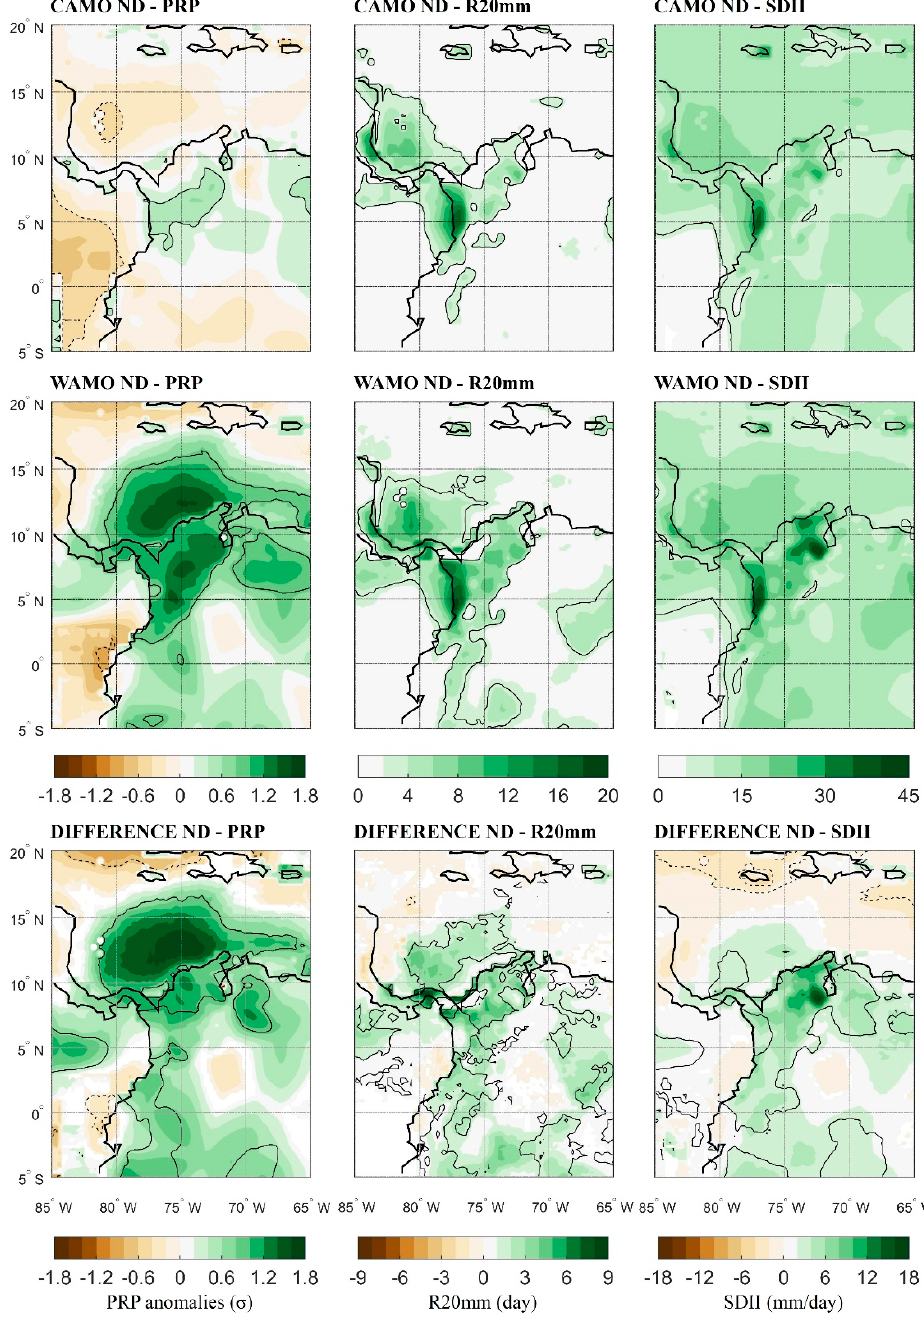
Figure 8. As in Figure 7 but for November–December (ND).